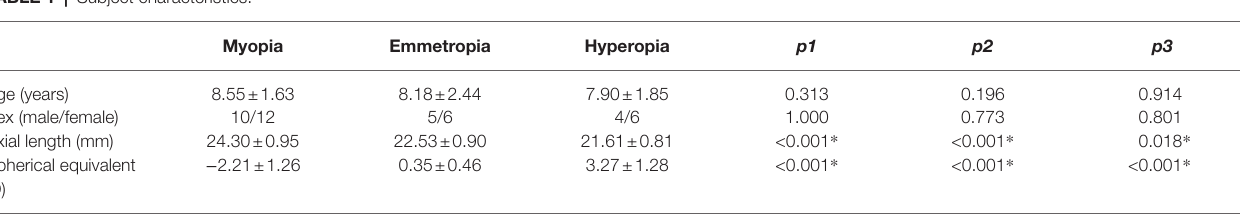
TABLE 1 | Subject